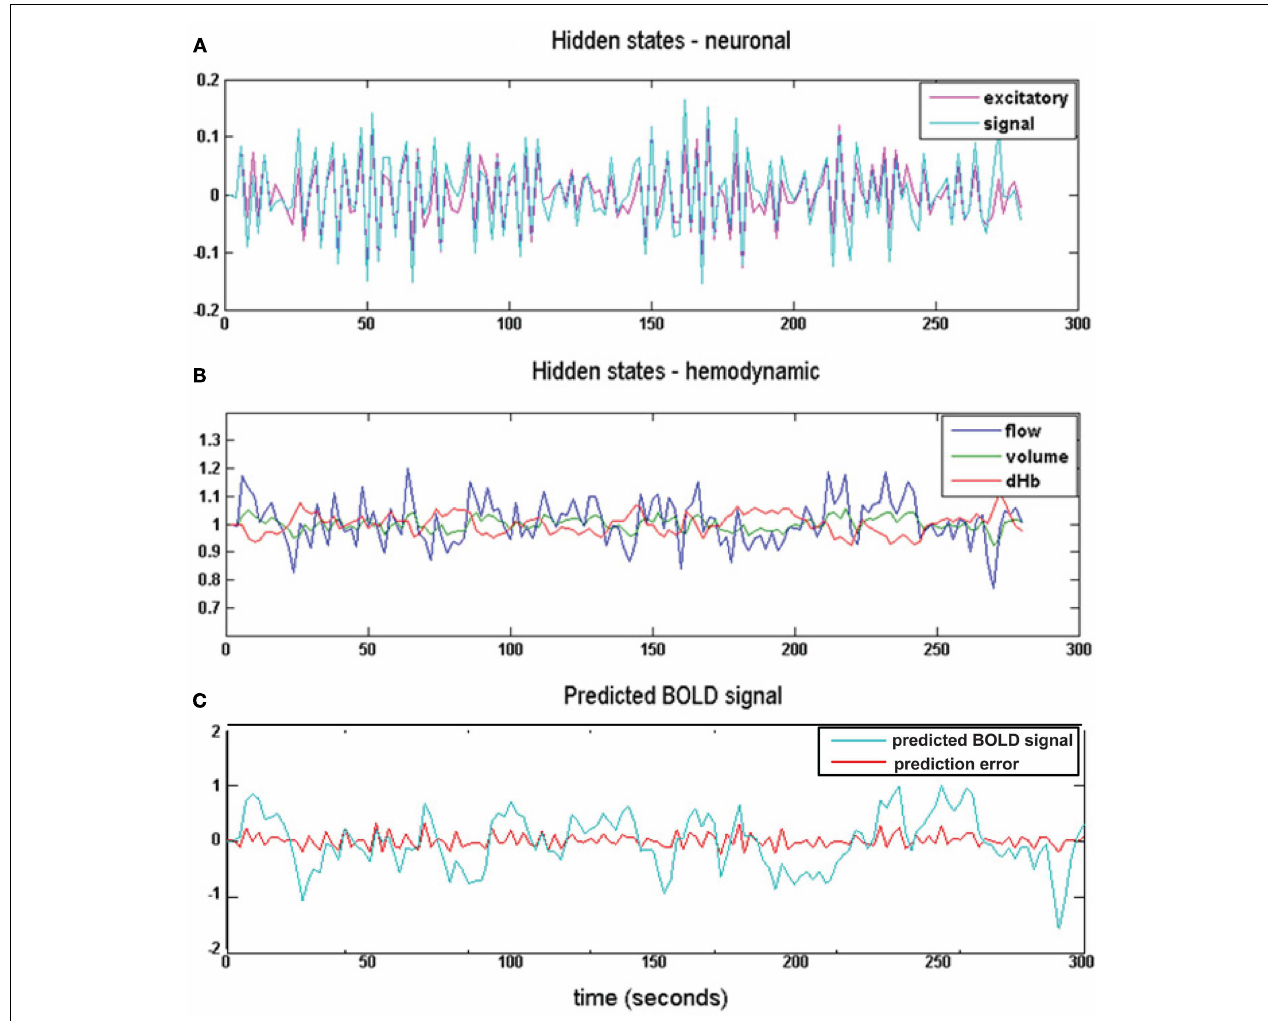
shown in the upper and middle (A,B) .The resulting BOLD time series are shown in terms of the model predictions and prediction error (C) .These results are shown as a function of time in scans for a region in the